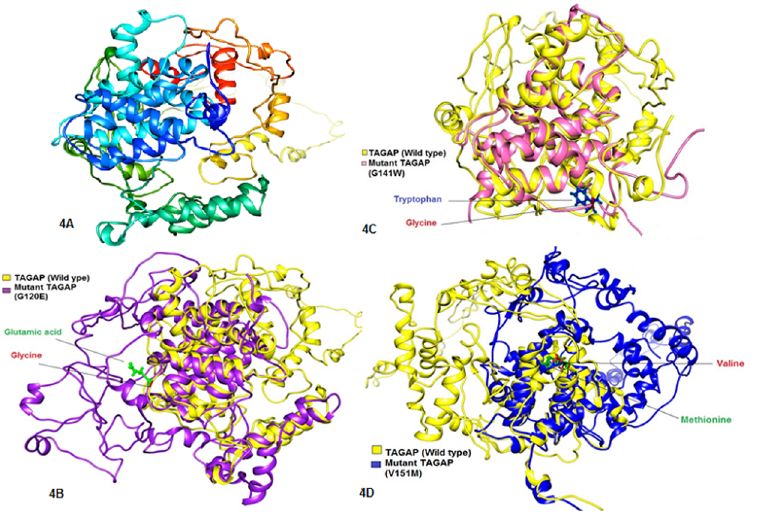
Fig 4. Comparison of wild type TAGAP protein structure with its mutant forms. (A) 3D model of wild type TAGAP protein. (B) Superimposed structures of wild type TAGAP protein and its mutant having mutation from Glycine to Glutamic Acid at position120. (C) Superimposed structures of wild type TAGAP protein and its mutant havingmutation from Glycine to Tryptophan at position 141. (D) Superimposed structures of wild type TAGAP protein and its mutant having mutation from Valineto Methionine at position